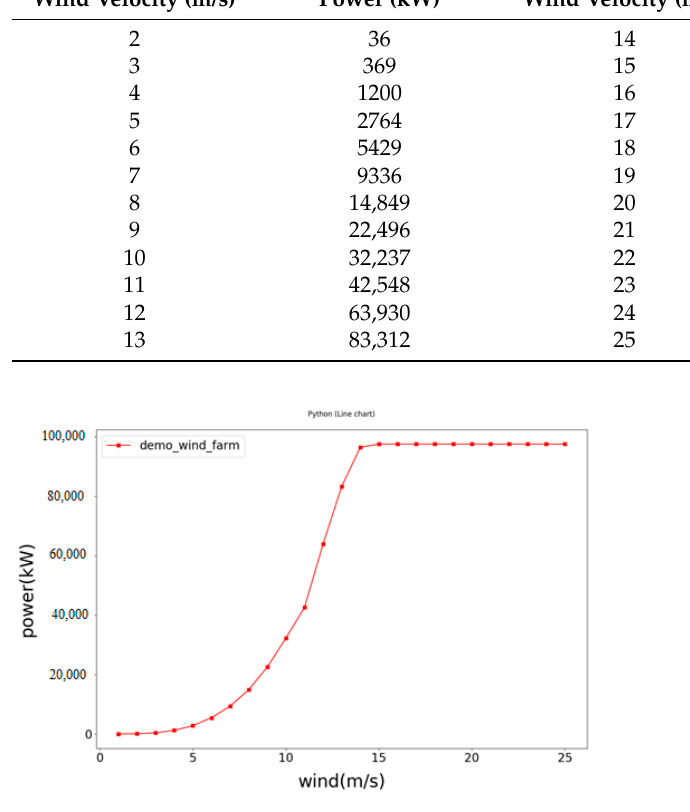
Figure 8. Wind velocity-dependent power output of the demonstration windfarm.